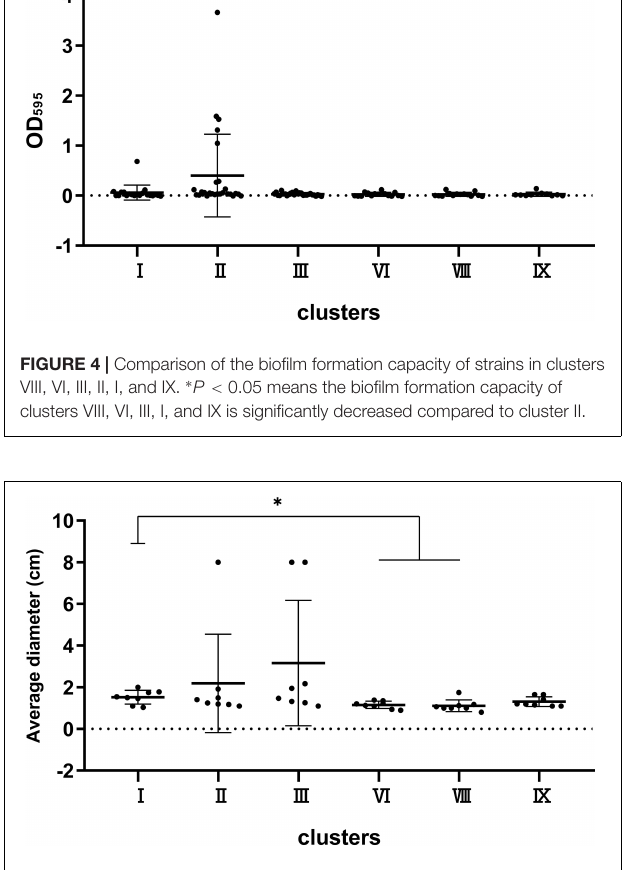
FIGURE 5 | Bacterial mobility capacity of strains in clusters I, II, III, VI, VIII, and IX. ∗ P < 0.05 means the swimming capacity of cluster I is significantly higher than clusters VI and VIII.